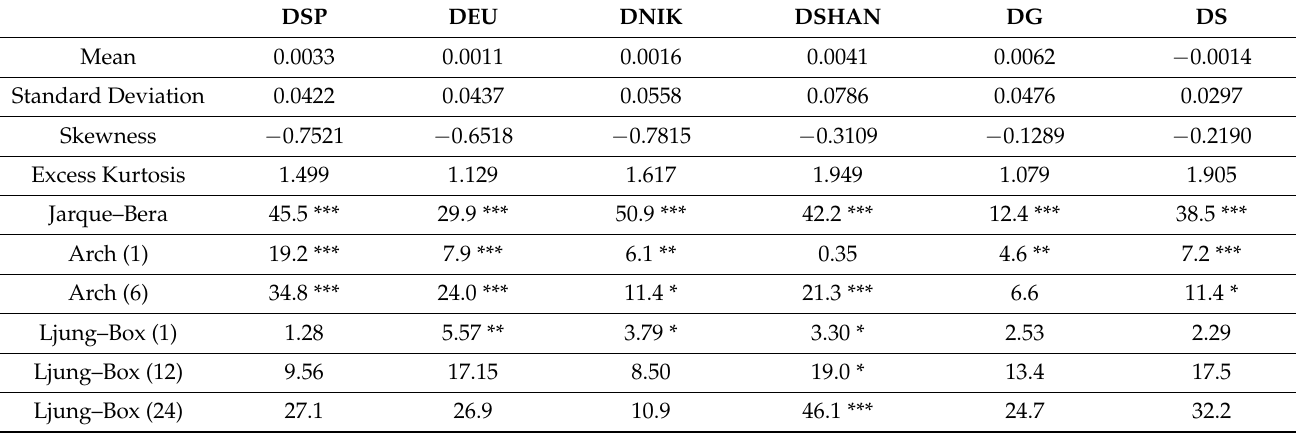
Table 1. Descriptive Statistics for Asset Returns. Monthly Data: 1999M2-2019M3 (242